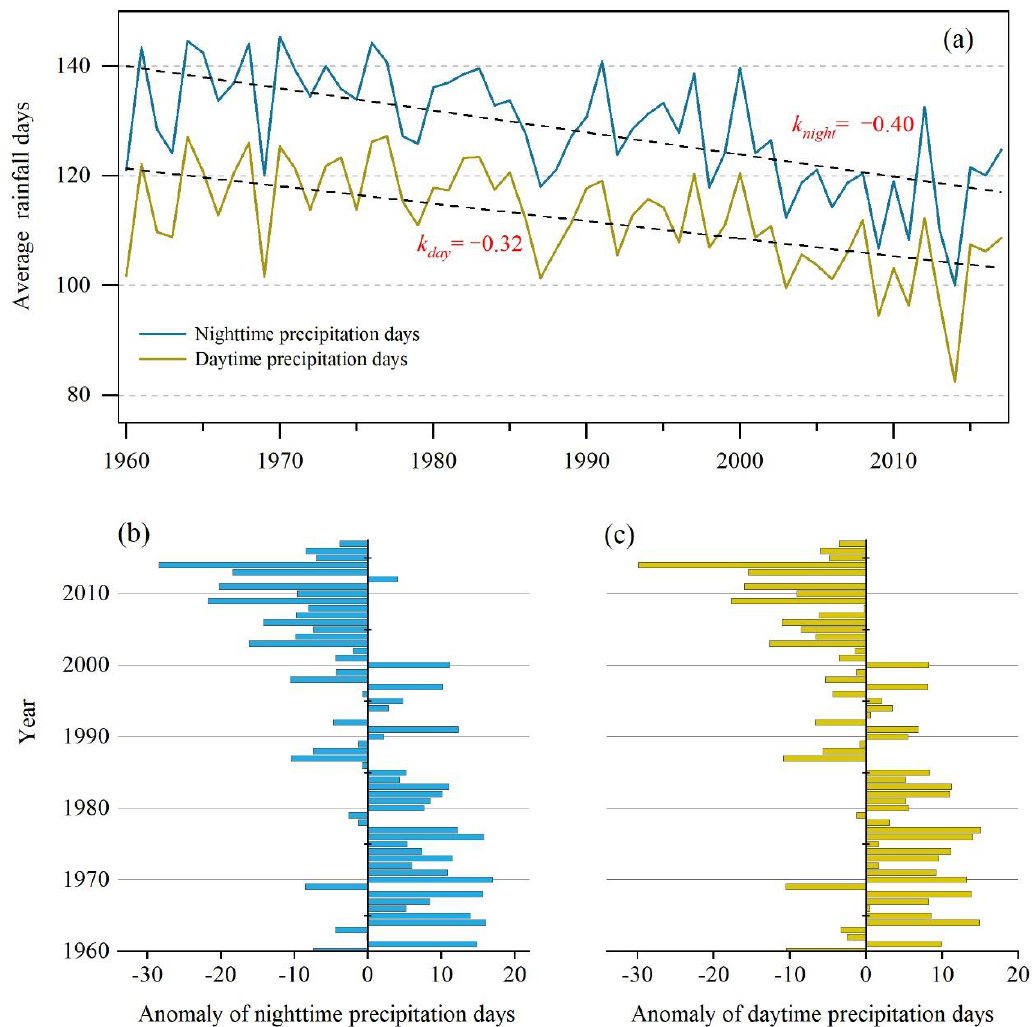
Figure 5. Average of daytime and night-time precipitation days and its anomaly statistics.